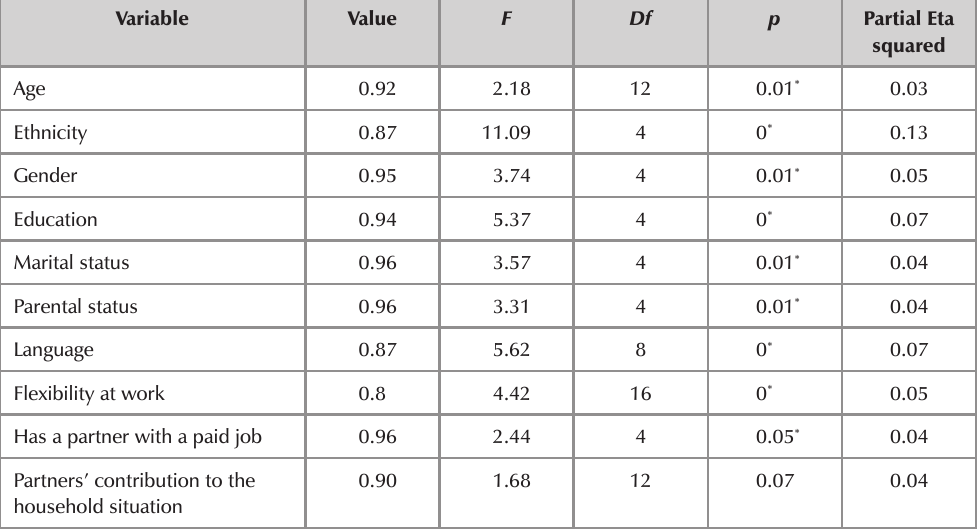
Differences in the work–home interaction levels of socio-demographic